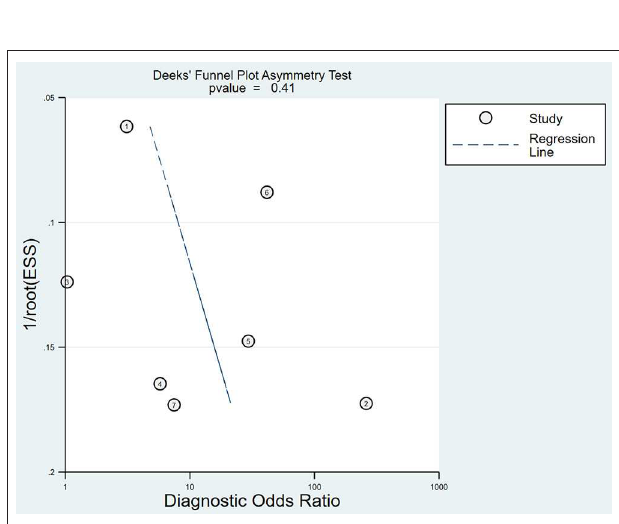
FIGURE 6 | Deeks’ funnel plot asymmetry test to evaluate publication bias.